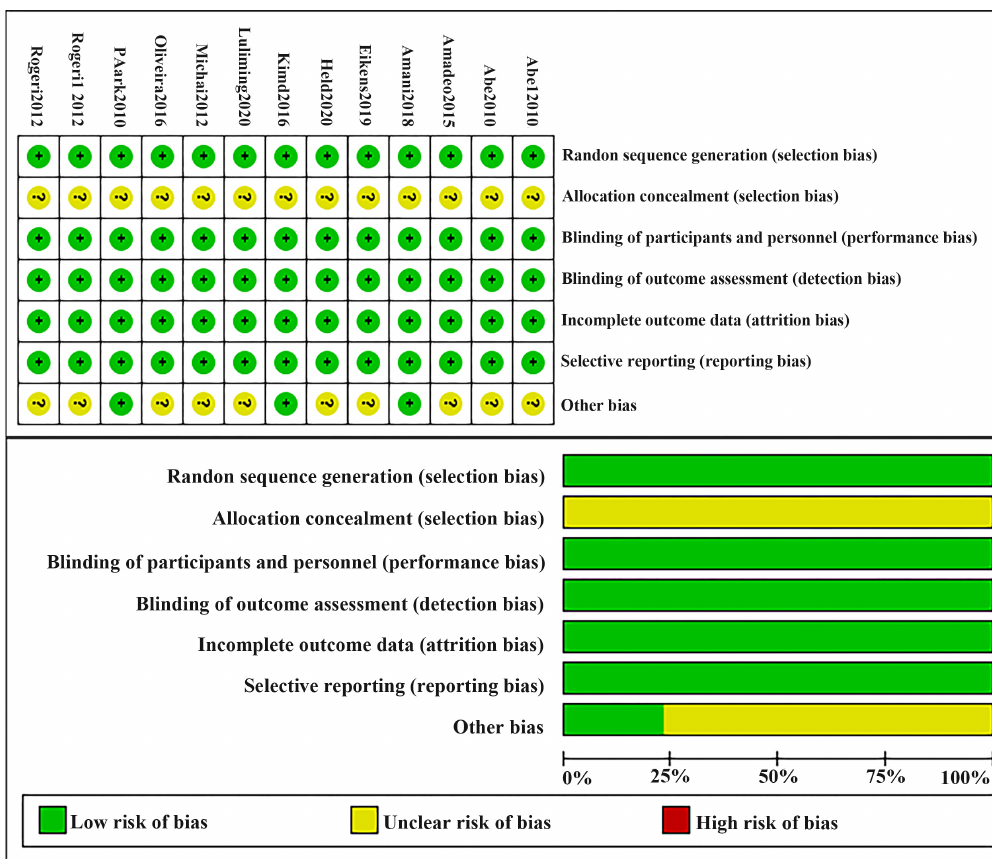
Fig. 3. Quality evaluation information chart.